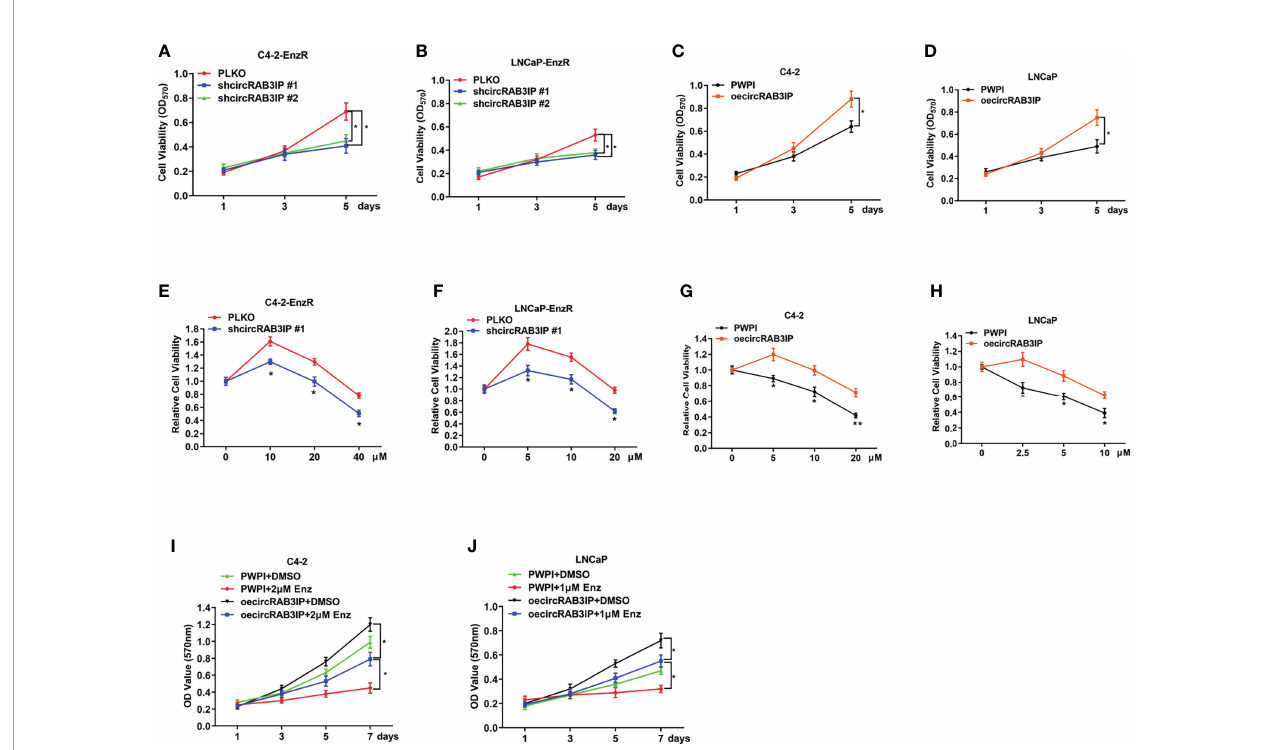
FIGURE 2 | (A) The proliferation ability of C4-2-EnzR cells was evaluated by MTT assay after knocking down circRAB3IP. (B) The proliferation ability of LNCaP- EnzR cells was evaluated by MTT assay after knocking down circRAB3IP. (C) The proliferation ability of C4-2 cells was evaluated by MTT assay after overexpressing circRAB3IP. (D) The proliferation ability of LNCaP cells was evaluated by MTT assay after overexpressing circRAB3IP. (E) C4-2-EnzR cells were treated with different concentrations of Enz as indicated after knocking down circRAB3IP #1, and cell viability was evaluated by CCK-8 assay. (F) LNCaP-EnzR cells were treated with different concentrations of Enz as indicated after knocking down circRAB3IP #1, and cell viability was evaluated by CCK-8 assay. (G) C4- 2 cells were treated with different concentrations of Enz as indicated after overexpressing circRAB3IP, and cell viability was evaluated by CCK-8 assay. (H) LNCaP cells were treated with different concentrations of Enz as indicated after overexpressing circRAB3IP, and cell viability was evaluated by CCK-8 assay. (I) C4-2 cells were treated with/without 1 m M Enz after overexpressing circRAB3IP or not (PWPI), and cell viability was evaluated by CCK-8 assay. (J) LNCaP cells were treated with/without 2 m M Enz after overexpressing circRAB3IP or not (PWPI), and cell viability was evaluated by CCK-8 assay. Data are presented as mean ± SEM. *P < 0.05, **P < 0.01 compared with the